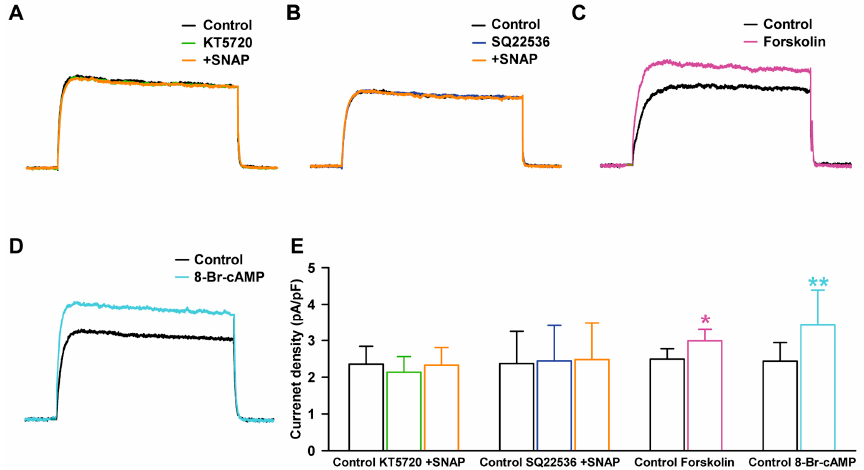
Figure 6. Effects of the protein kinase A (PKA) pathway on the stimulating effect of NO on I K current. Representative currents showing the effect of SNAP on I K after pretreatment with ( A ) KT5720 or ( B ) SQ22536. Effect of ( C ) forskolin or ( D ) 8-Br-cyclic AMP on I K . ( E ) Bar graph summarizing current density changes for the effects of SNAP on I K after pre-incubation with KT5720 or SQ22536, and the effect of forskolin or 8-Br-cAMP on I K . * p < 0.05, ** p < 0.01 versus the control.